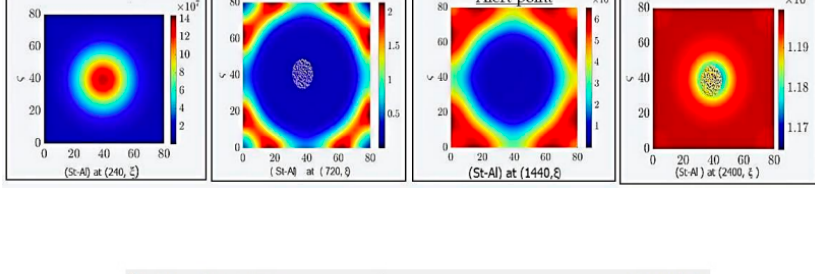
Figure 5. The change in the (Al-Fe) gasket alloy resistance working conditions for thermal transfer. a: The behavior of the cracks’ growth through 23 weeks for the Fe-Al alloy is uniform.